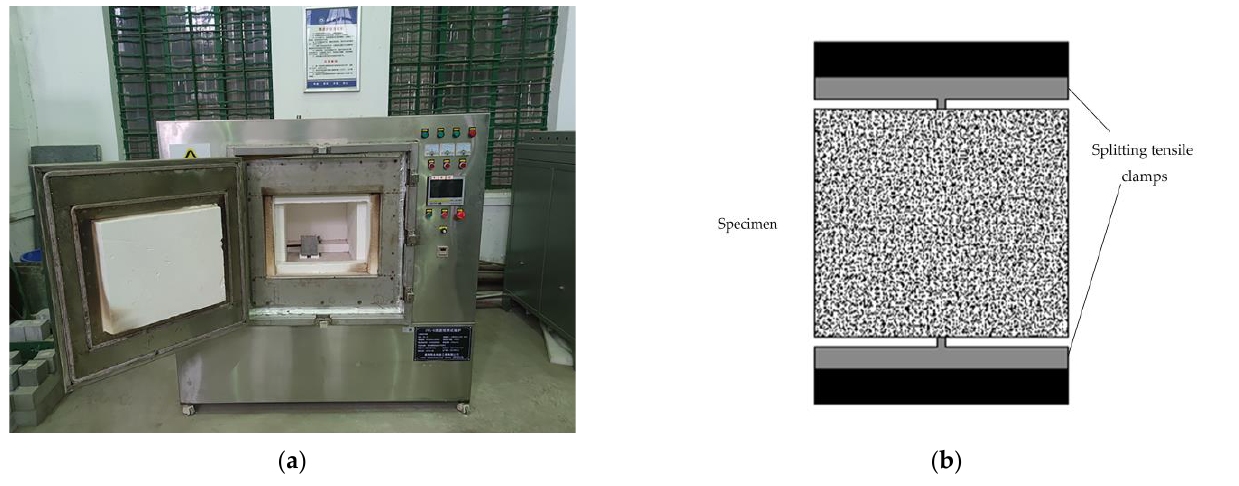
Figure 2. ( a ) Heating diagram; ( b ) Schematic diagram of splitting tensile test.